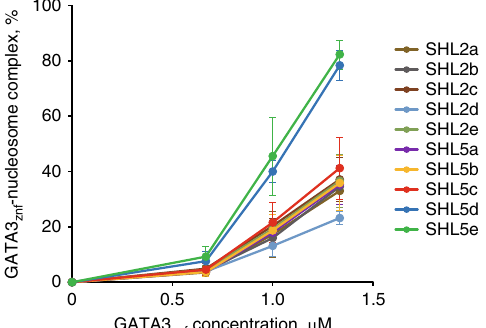
Fig. 2 GATA3 znf binds nucleosomal target DNA. a Design of the GATA3 target nucleosomes. Red arrows indicate the introduced 5 ′ -GAT-3 ′ (or 5 ′ -ATC- 3 ′ ) sequences. Blue arrows indicate 5 ′ -GAT-3 ′ (or 5 ′ -ATC-3 ′ ) sequences originally contained in the Widom 601 sequence. Right arrows indicate 5 ′ -GAT-3 ′ sequence. Left arrows indicate 5 ′ -ATC-3 ′ sequence. b Electrophoretic mobility shift assay (EMSA) of the GATA3 target nucleosomes with GATA3 znf . The nucleosome (0.33 μ M) was mixed with GATA3 znf (0, 0.67, 1.0, and 1.33 μ M). The reaction mixtures were incubated at 25 °C for 30 min and were then analyzed by native-PAGE. The gel was stained with ethidium bromide. Lanes 1 – 4, 5 – 8, 9 – 12, 13 – 16, 17 – 20, 21 – 24, 25 – 28, 29 – 32, 33 – 36, and 37 – 40 indicate results for the nucleosomes containing SHL2a, SHL2b, SHL2c, SHL2d, SHL2e, SHL5a, SHL5b, SHL5c, SHL5d, and SHL5e, respectively. Three independent experiments were performed, and the reproducibility was con fi rmed (Supplementary Fig. 3). c Quanti fi cation of the results shown in b . The average % values of three independent experiments shown in b and Supplementary Fig. 3 were plotted against the GATA3 znf concentration. Data are represented as mean values ± SD ( n = 3 independent biological replicates). Source data are provided as a Source Data fi GATA3 (GATA3 znf ) was puri fi ed as a recombinant protein (Supplementary Fig. 2c). We tested the GATA3 znf binding to the nucleosome by an